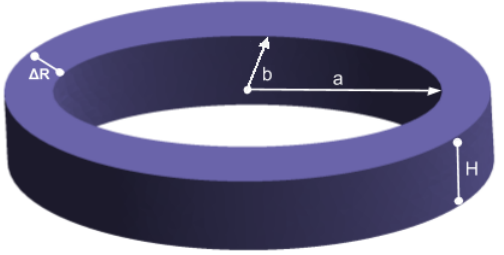
Figure 4. A schematic representation of the elliptical ring geometry.